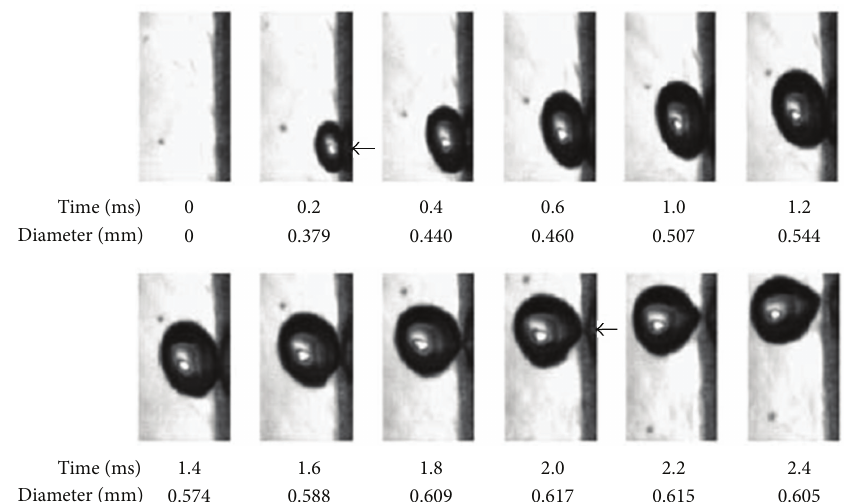
Figure 6: The typical photos of bubble growth in subcooled flow boiling in Rong Situ [11] experiment.